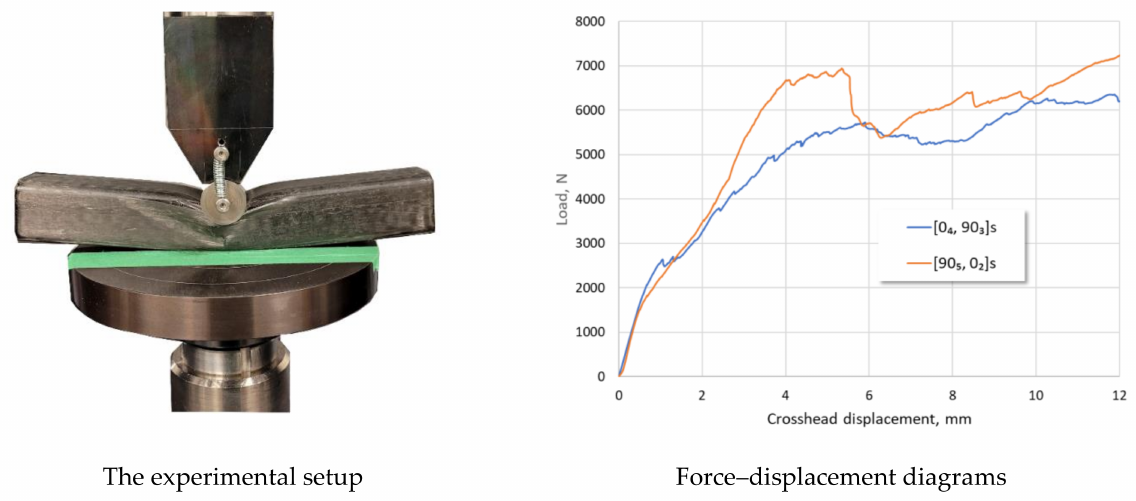
Figure 5. Transverse crushing of the tubular NCF specimen.